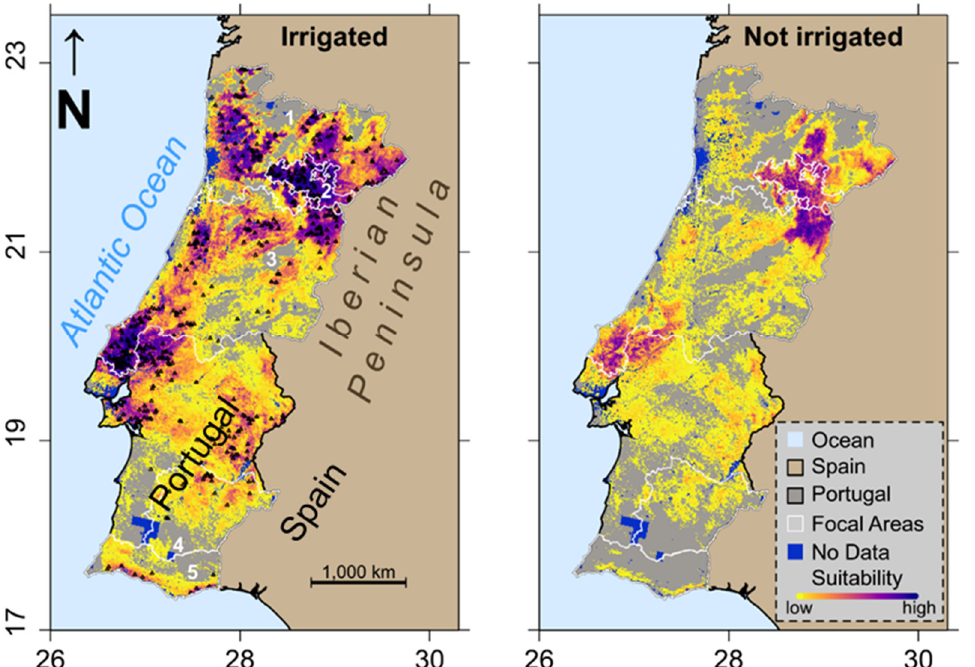
Figure 2. Predictions (EPSG:3035) for the baseline period (1981–2010) with coordinates in hundreds of kilometers. Darker colors indicate higher suitability; suitability falls short of the 10th percentile threshold, and no data regions are shown in gray and dark blue, respectively. The outlines of the Douro wine region and the other focal areas are displayed in white. In the left panel, we also overlay a systematic subset of 500 out of 7002 presences (black triangles) to allow for a visual assessment of the prediction and numeric labels (1–5) to identify different regions: “1” Norte, “2” Douro wine region, “3” Centro, “4” Baixo Alentejo, and “5” Algarve. ( Left ) Actual proportions of area equipped for irrigation are used; ( right ) the proportion of area equipped for irrigation is assumed zero across the study area. Geographic labels are added in the first panel for faster orientation.